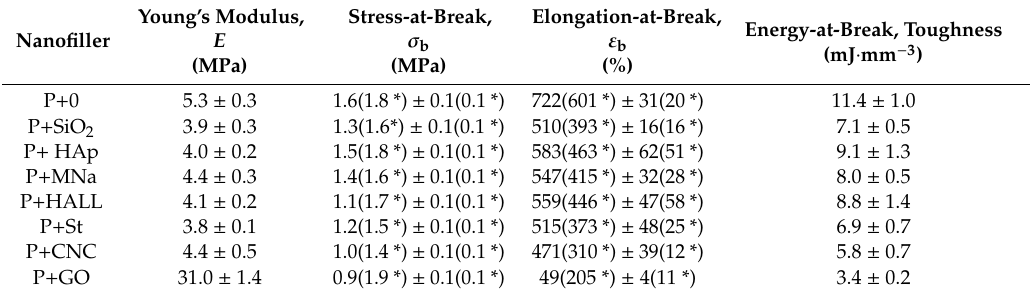
Table 1. Tensile characteristics of the neat poly(urethane-urea), PUU and PUU nanocomposite films.